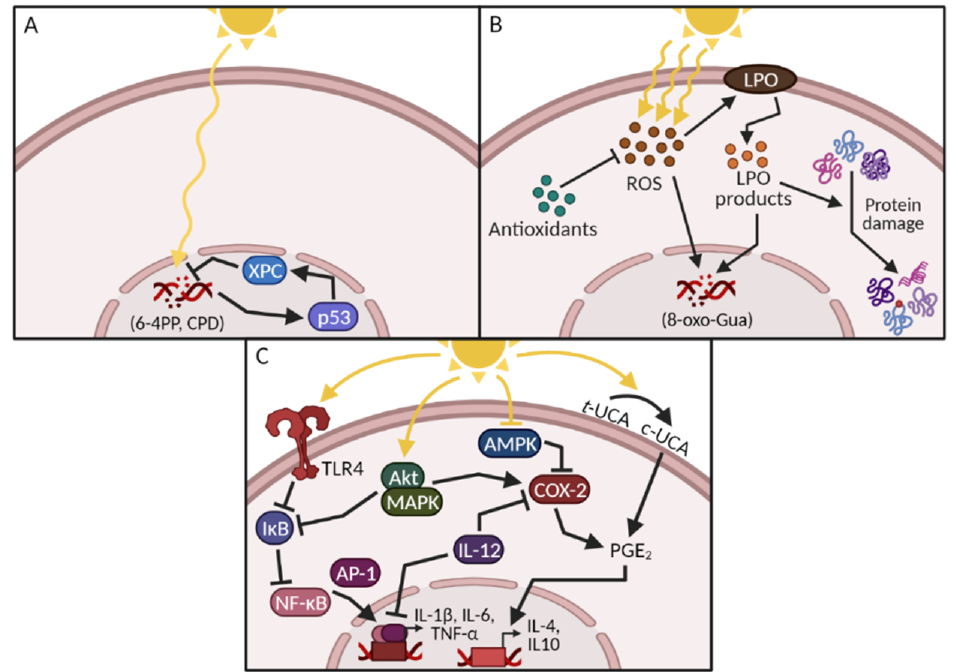
Figure 1. Simplified schematic of ( A ): UV-induced DNA damage caused by direct UV absorption by the DNA molecules resulting in DNA lesions such as 6–4 photoproducts (6–4PPs) or cyclobutane pyrimidine dimers (CPDs) which are repaired by XPC and the nuclear excision repair pathway; ( B ): UV-induced oxidative stress caused by increased reactive oxygen species (ROS) production resulting in damaged DNA (8-oxo-hydroxyguanine lesions), lipid (lipid peroxidation; LPO) and protein (carbonylation and other irreversible changes) molecules; ( C ): UV-induced inflammation, immunosuppression and signal transduction caused by dysregulated mitogen-activated protein kinase (MAPK) activity resulting in activation and transcription of inflammatory mediators. Furthermore, UV radiation induces immunosuppressive mediators via the photoisomersiation of trans -urocanic acid (UCA) to cis -UCA. Abbreviations: AMPK: AMP-activated protein kinase, AP-1: activator protein 1, COX-2: cyclooxygenase 2, IL: interleukin, PGE 2 : prostaglandin E 2, TLR4: Toll-like receptor 4.